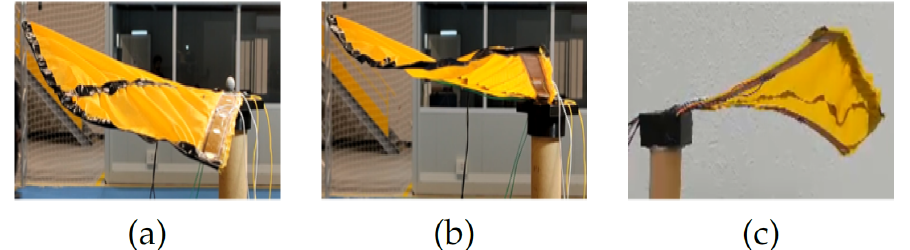
Figure 6. Bio-inspired Tail Control Configurations. ( a ) Asymmetric YAW. ( b ) Symmetric PITCH.